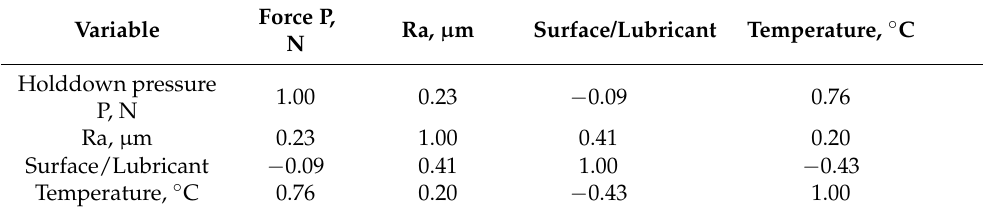
Table 5. Parameter cross-correlations matrix. Marked correlations are significant at p < 0.05. N = 12 (casewise deletion of missing